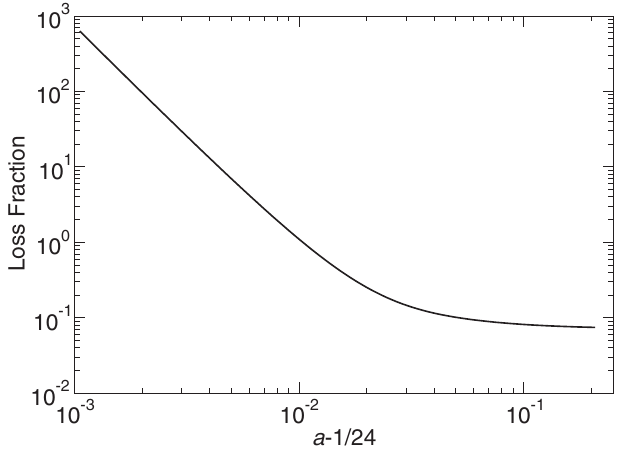
FIG. 17. Fractional loss as a function of a for the muon FFAG described in the